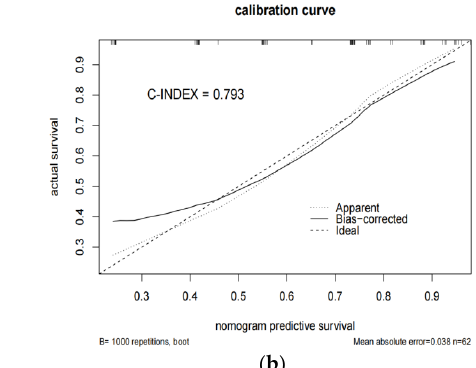
Figure 2. Receiver Operating Characteristic (ROC) analysis of peripheral blood parameters to pre- dict induction chemotherapy (IC) response in advanced laryngeal squamous cell carcinoma (LSCC). ( a – d ) ROC analysis of peripheral blood parameters to predict IC response (AUC > 0.58); ( e ) ROC analysis of the blood model to predict IC response; ( f ) comparison between the blood model and conventional TNM stage model to predict IC response by ROC analysis.